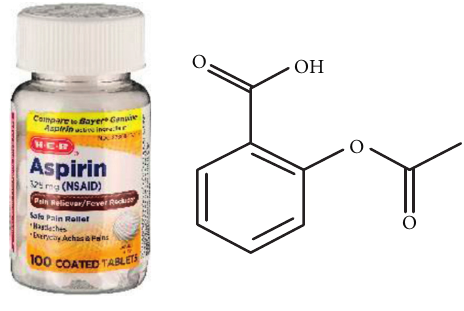
Figure 2: Graph structure of aspirin. Table 3: Atoms dataset of the graph structure of aspirin.